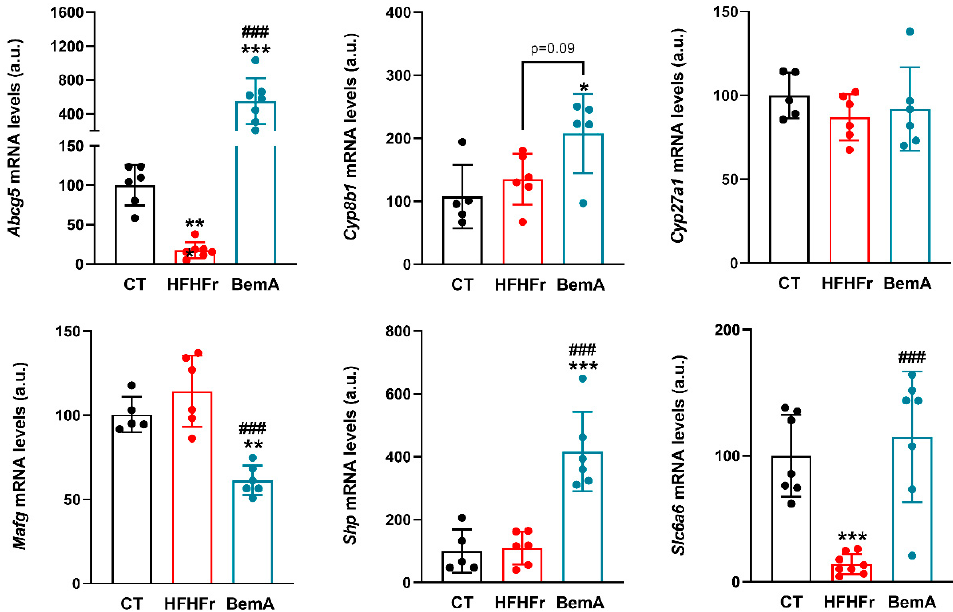
Figure 4. Relative expression of several genes under FXR transcriptional control in liver samples. Bar plots show the relative mRNA levels of abcg5 , cyp8b1 , cyp27a1 , mafg , shp , and slc6a6 genes as mean ± SD, as well as individual values from 5-8 tissue samples, corresponding to the three experimental groups studied: CT (control), HFHFr (high-fat high-fructose), and BemA (HFHFr treated with BemA) female Sprague-Dawley rats. * p < 0.05, ** p < 0.01, *** p < 0.001, vs. CT; ### p < 0.001 vs. HFHFr.